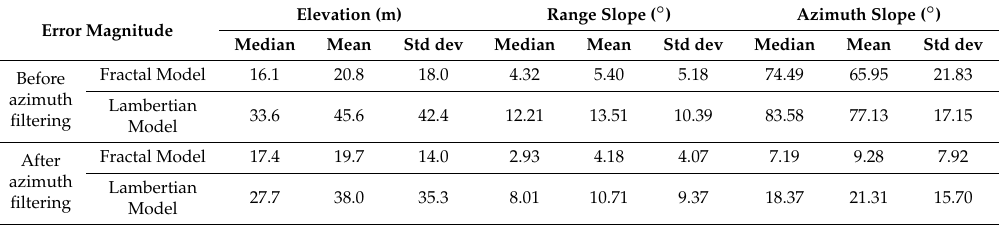
Table 4. Quality measures for the sinusoidal DEM: speckle case; known starting points in range integration. Error